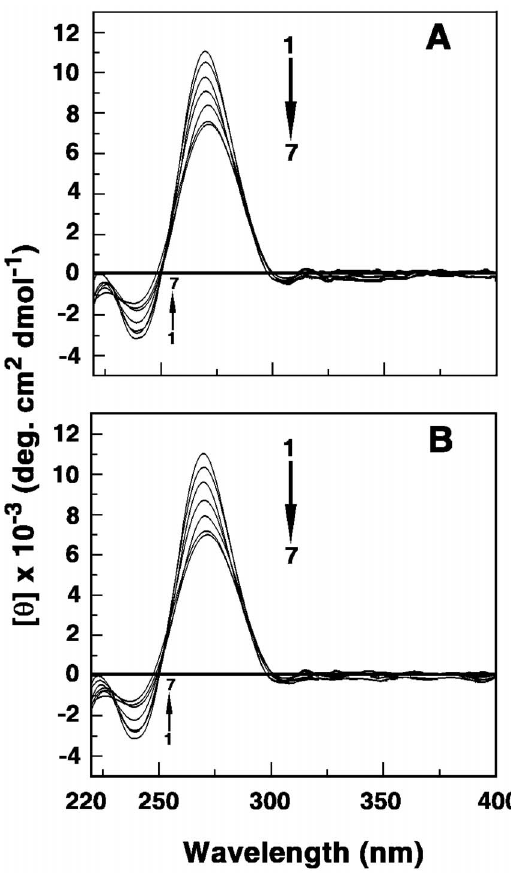
Figure 5. Circular dichroism spectra of the alkaloid-tRNA complexes. tRNA (50 m M) treated with increasing concentrations of analogs (A) B2 and (B) B4. doi:10.1371/journal.pone.0058279.g005 representative calorimetric titration of analog B2 and B4 into the solution of tRNA at 20 u C is presented in Fig. 6. Each injection heat burst curve in the figure corresponds to a single injection. These injection heats were corrected by subtracting the corre- sponding dilution heats derived from the titration of the alkaloid into buffer (Fig. 6, top panel, curves offset for clarity). In Fig. 6 (bottom panel) the resulting corrected heats are plotted against the respective molar ratio. In this panel the data points reflect the experimental data and the continuous line represents the calculated fits of the data to the binding model. The binding was characterized by exothermic heats. The corrected isotherms obtained at 20 u C showed single site binding in all the cases indicating that one type of complexation is formed exclusively, thus enabling the fitting to a single site protocol. Fitting to one site model was also supported by the results from the Job plot analysis (vide supra). The results of the ITC experiments are presented in Table 2. The binding affinity values ( K a ) are of the order of 10 5 M 2 1 for the analogs B2-4 which is remarkably higher in comparison to BER that had affinity of 8.6 6 10 4 M 2 1 . It is pertinent to note that analog B4 exhibited almost 10-fold higher binding affinity in comparison to BER. The interaction of the analog B1 with tRNA, the binding was negligible with only background heats. The binding affinity varied in the order B4 . B3 . B2 . BER. The binding affinity values from ITC clearly suggested a drastic reduction in the affinity from BER to analog B1